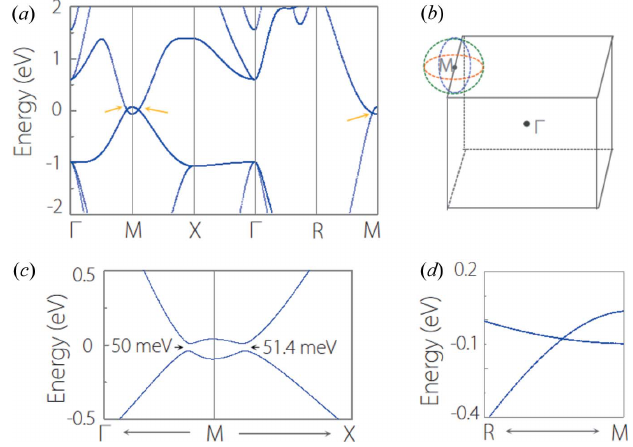
Figure 7 ( a ) Electronic band structure of CaTe without SOC. ( b ) Schematic illustration of the three crossing nodal lines in CaTe. ( c ) and ( d ) show the enlarged band structure of CaTe with SOC at the (cid:2) – M – X and R – M paths, respectively.